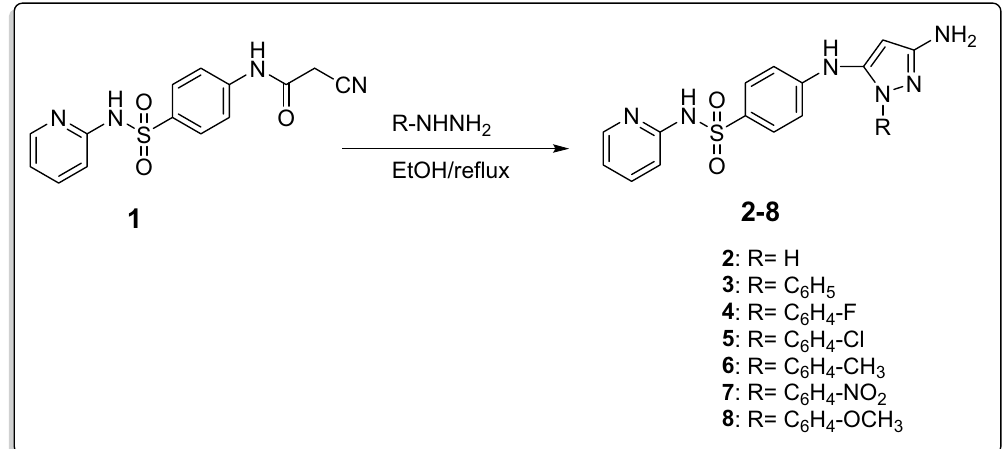
Figure 4. Synthetic route for compounds 2 – 8